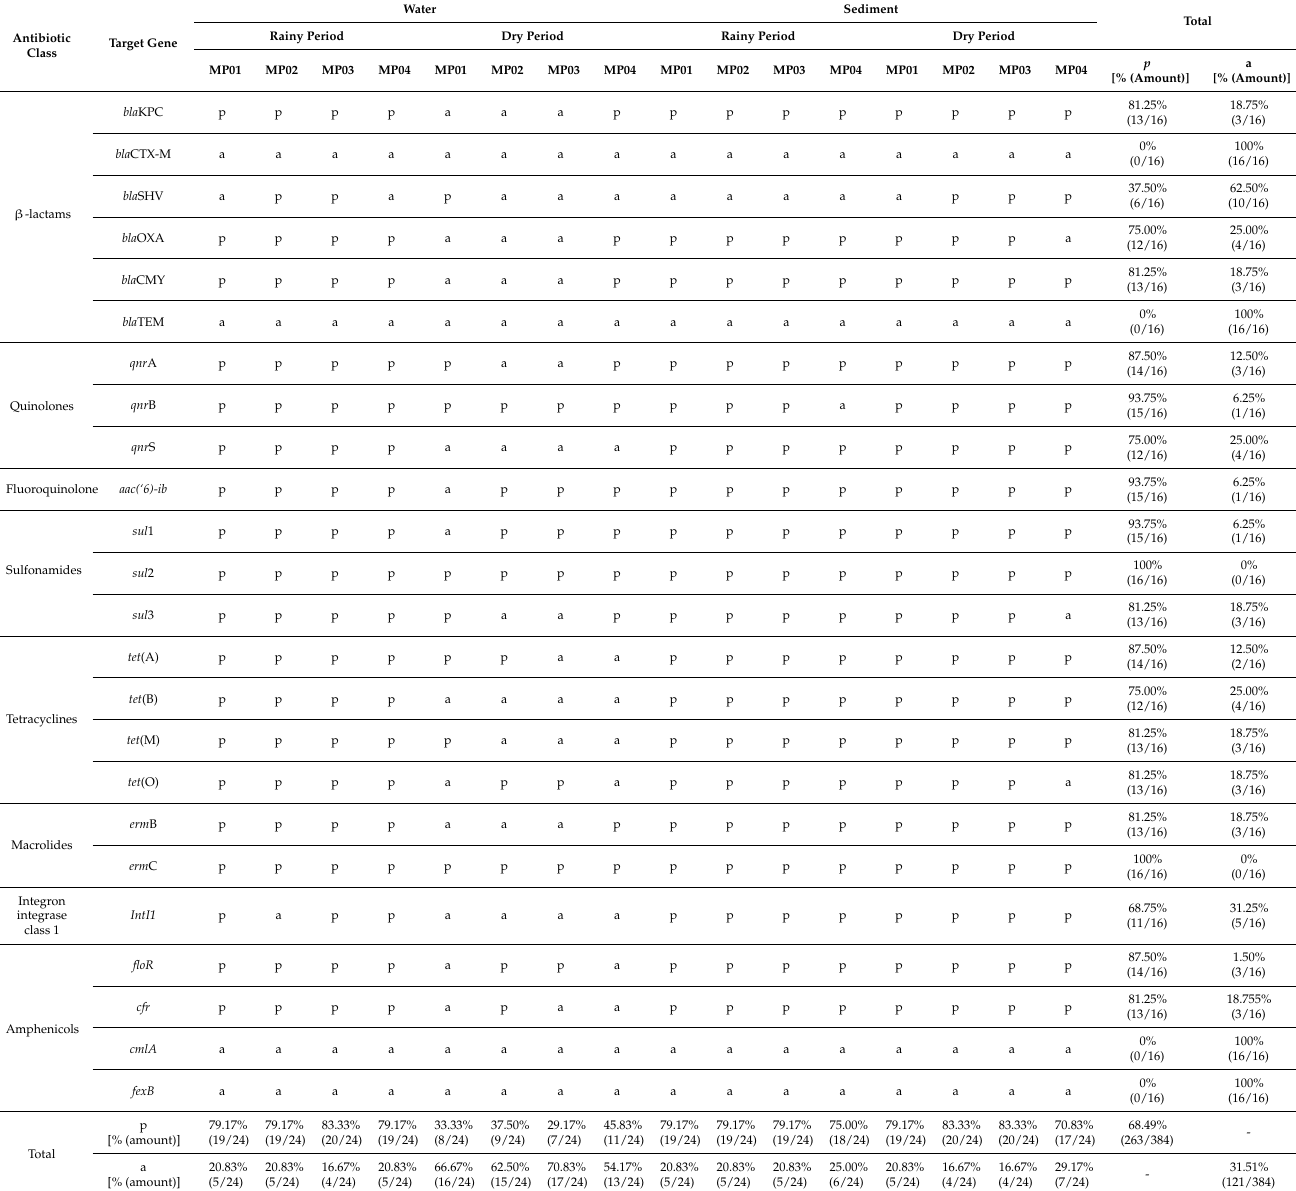
Table 4. Presence or absence of resistance genes in water and sediment samples from Meia Ponte